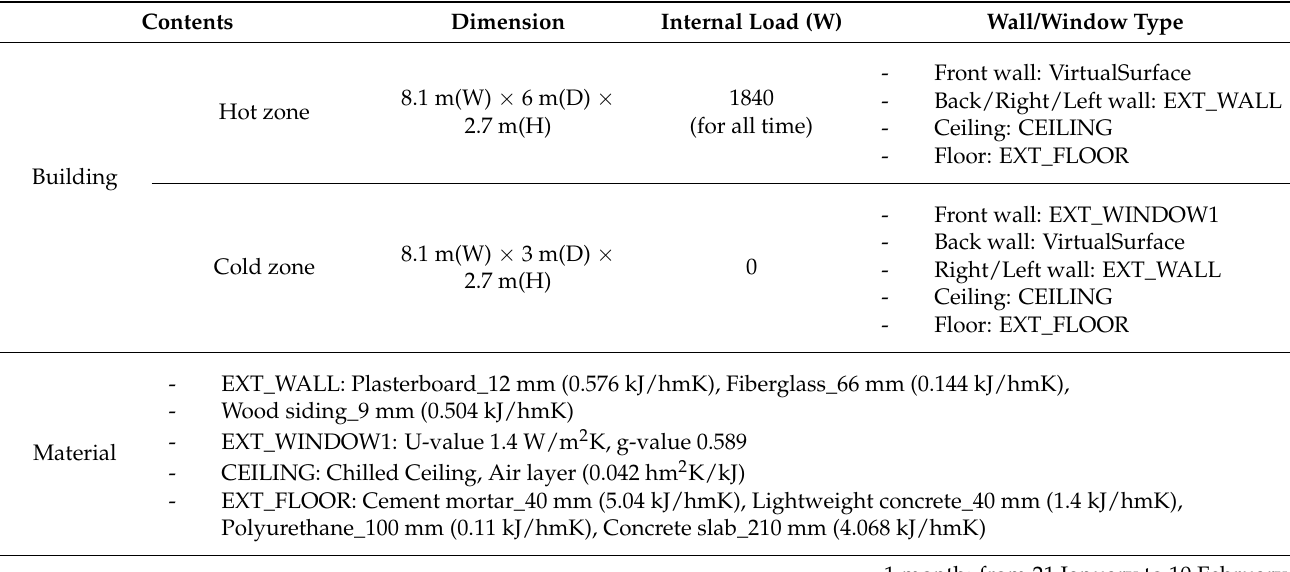
Table 4. Simulation input